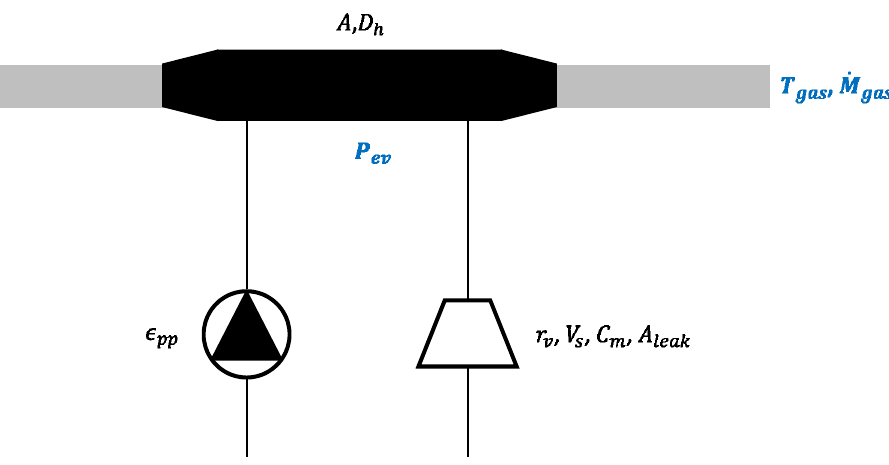
Figure 5. Overview of the Rankine cycle model, the set parameters and the inputs of the